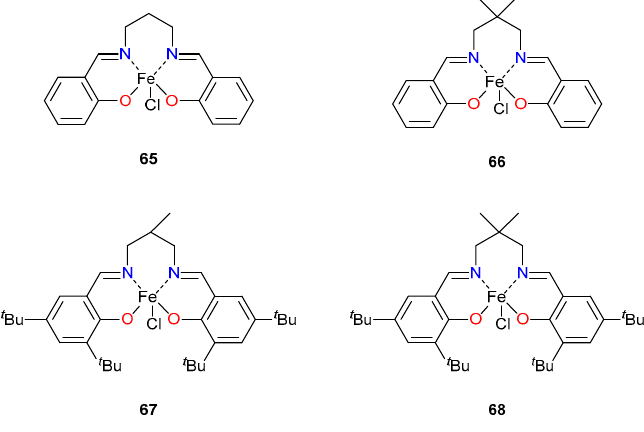
Figure 11. Fe(III) salen complexes 65–68 [56].